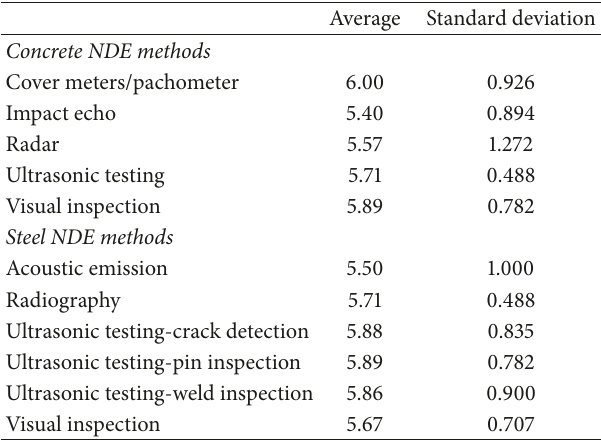
Table 2: Concrete and steel NDE methods response descriptive statistics for the